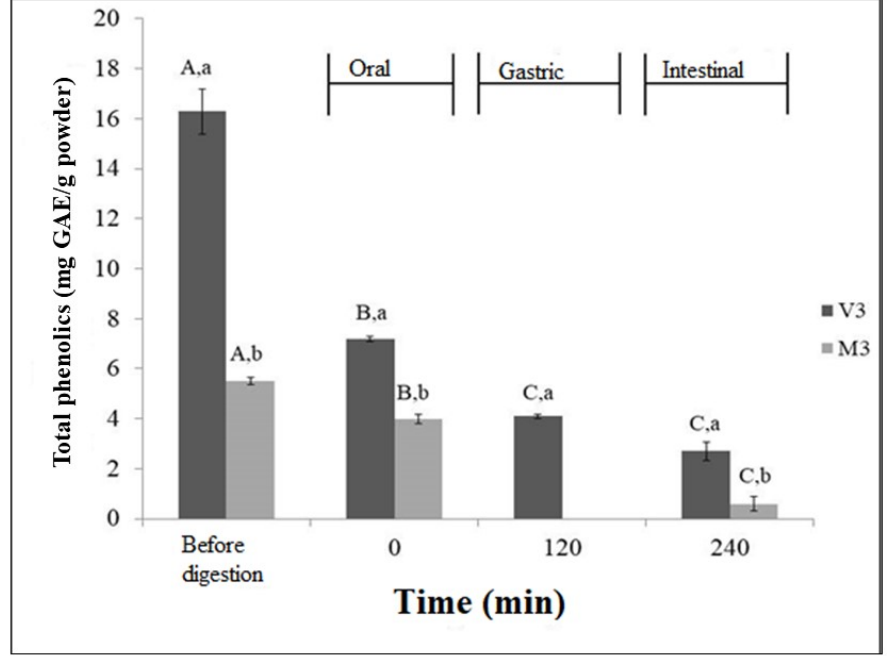
Figure 4. Release of phenolic compounds from encapsulated papaya seed extracts in simulated gastrointestinal fluids.